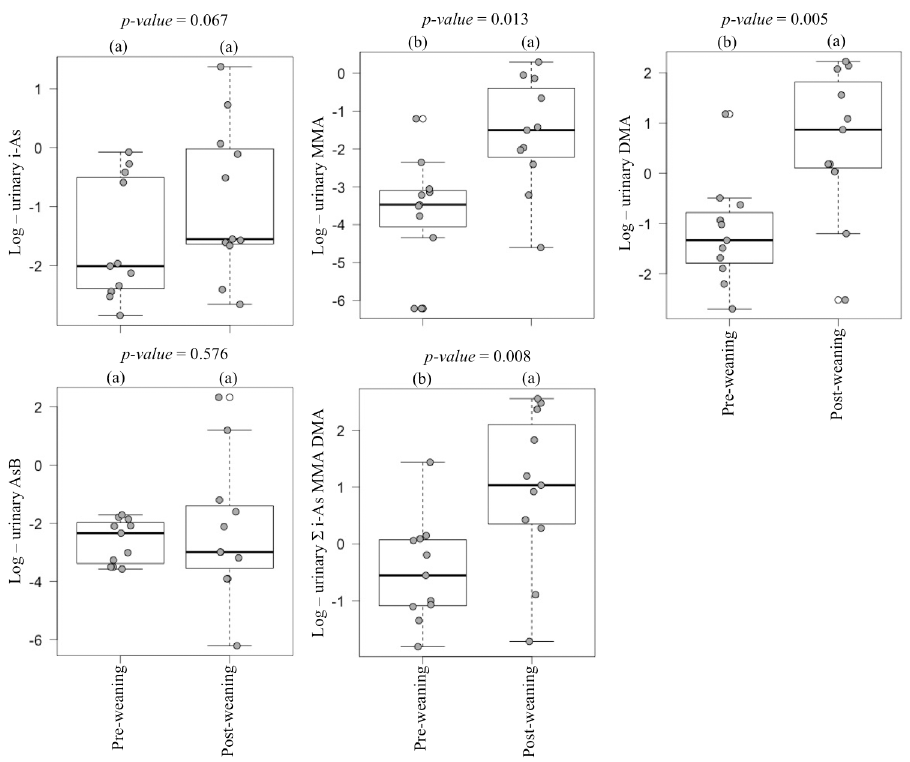
Fig 2. Urinary As species natural log concentrations in paired samples before and after weaning (Values with the same letters were not significantly different at p -value < 0.05 for the variable studied).